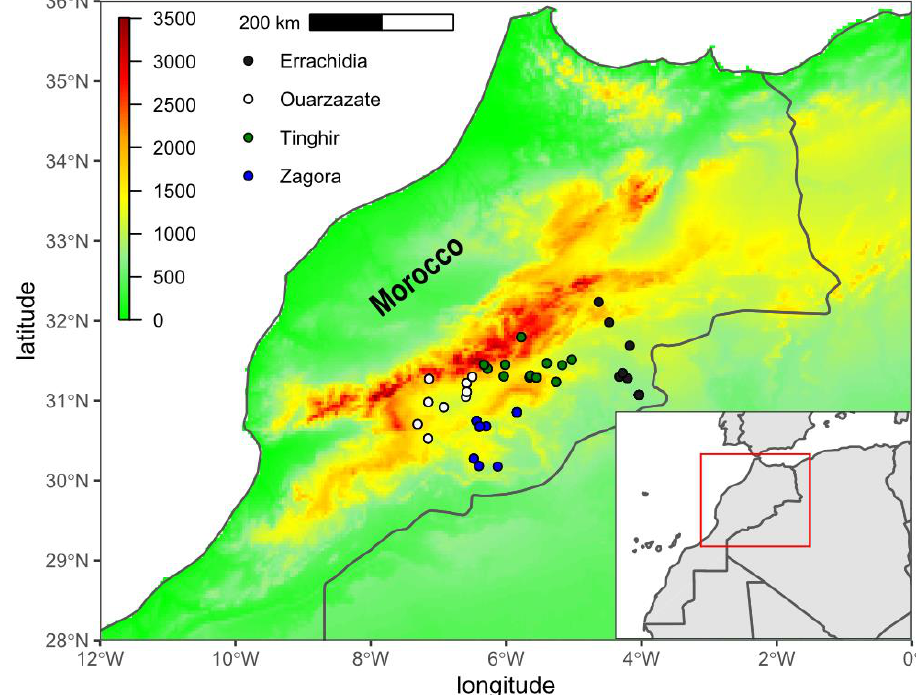
Figure 1. A map of Morocco with the Darâa-Tafilalet region where the sampling took place. The markers indicate the locations from which the samples were collected. Colour of the markers indi- cates four areas covered by this study.